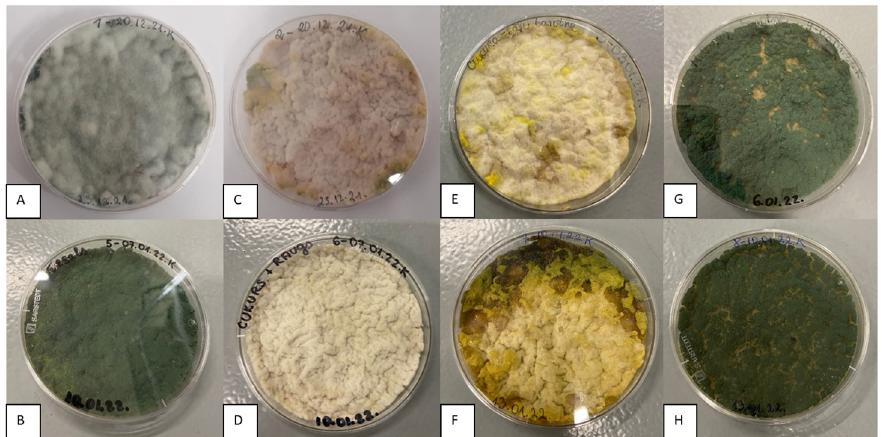
Figure 4. The morphological features of T. asperellum biomass (cultivated in bioreactor) depending on the composition of the culture medium after 5 days. The biomass was transferred to a Petri plate prior to adjustment of pH to 4. Individual picture designation regarding the medium used: ( A )—